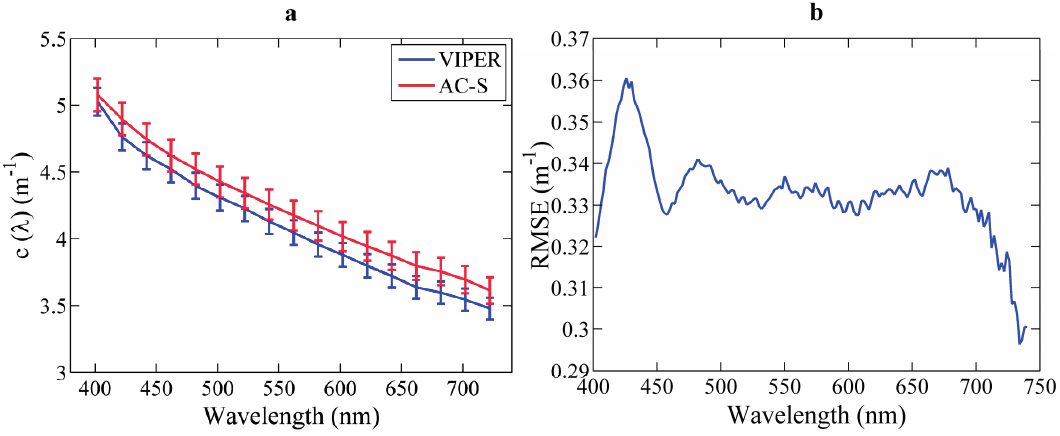
Figure 11. ( a ) Mean average and standard error of the spectral beam attenuation measured by VIPER (blue) and by AC-S (red) in Alfacs Bay, respectively; ( b ) Root mean square error between VIPER and AC-S at different wavelengths for the analyzed